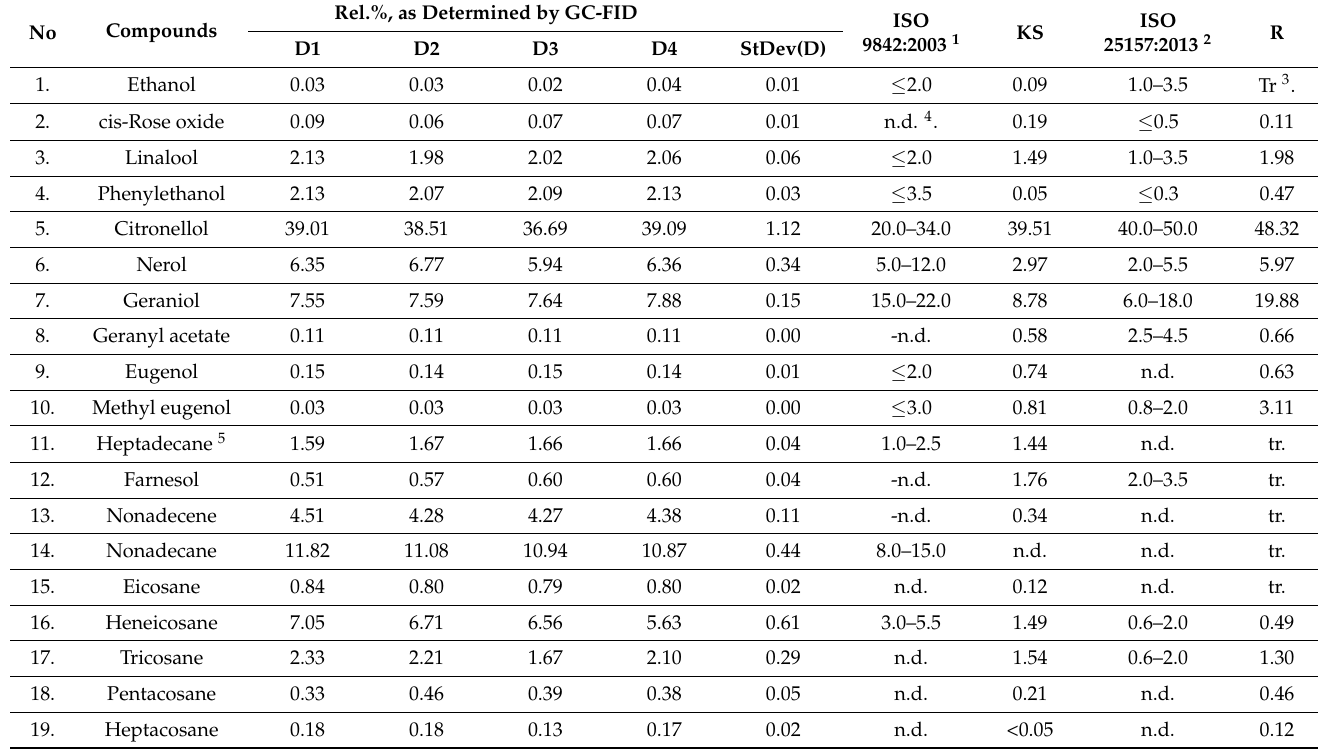
Table 2. The most important Chinese rose oil components, together with the ISO 9842:2003 and ISO 25157:2013